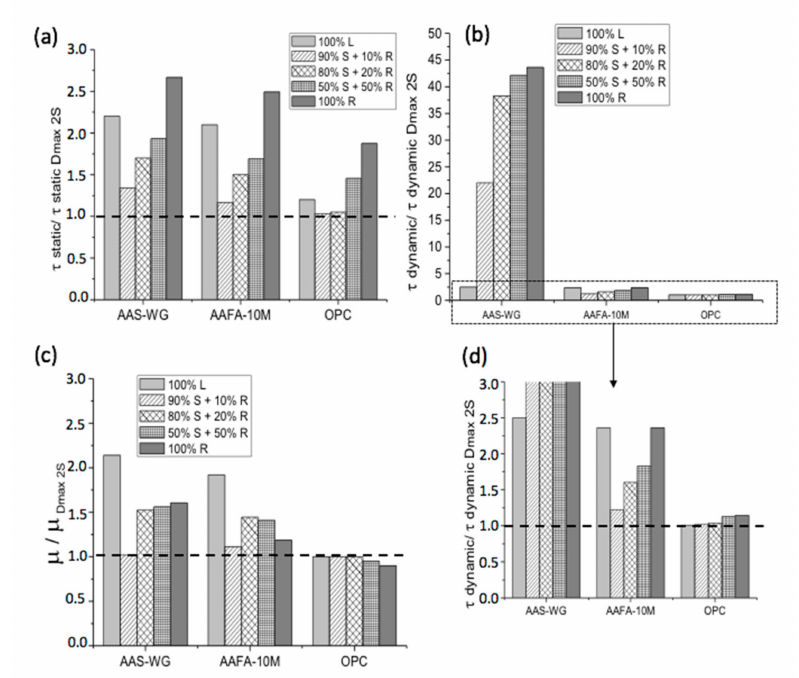
Figure 5. Variation in ( a ) static ( τ static ) and ( b , d ) dynamic ( τ dynamic ) shear, and ( c ) plastic viscosity ( µ ), when siliceous (S) aggregate was replaced with 100% limestone (L), or di ff erent percentages of recycled (R) aggregate. Values have been normalized with respect to the mortars with 100% siliceous aggregate and a D max = 2